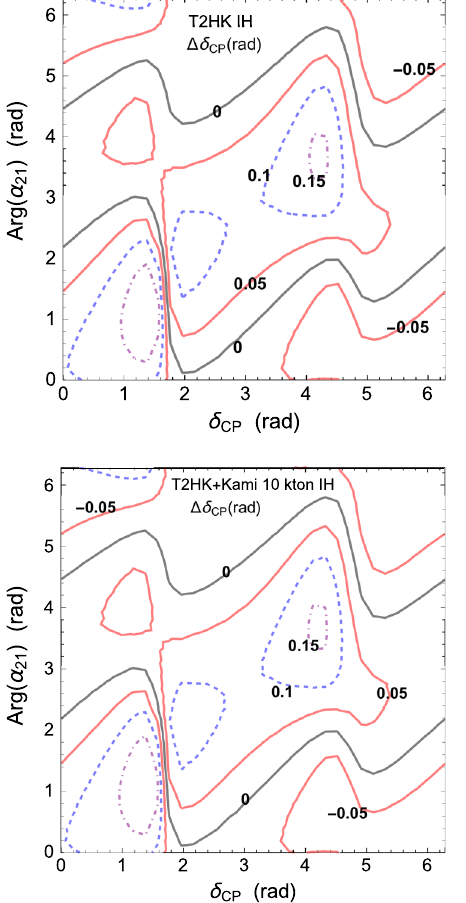
Fig. 6 The difference between the true value of δ CP , and the value that minimizes χ 2 ((cid:20)) of Eq. (32) with the true mass hierarchy. The bench- mark with Eq. (26) is assumed, and the true mass hierarchy is inverted. The upper-left, upper-right and lower-right subplots correspond to the T2HK, the T2HKK, and the plan of the T2HK plus a 10 kton water